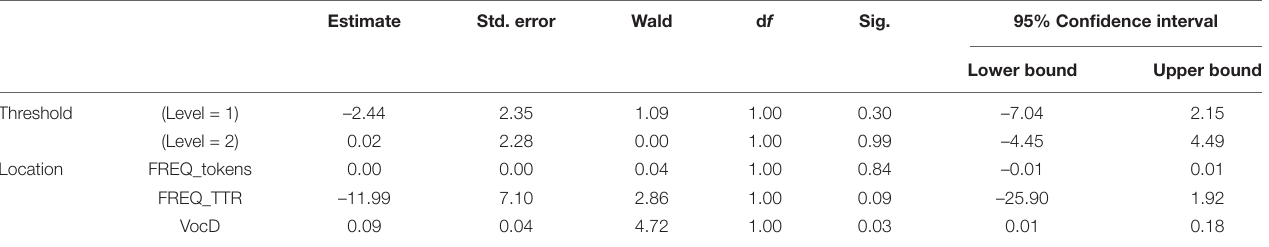
TABLE 4 | Ordinal logistic regression of vocabulary complexity indicators predicting grade